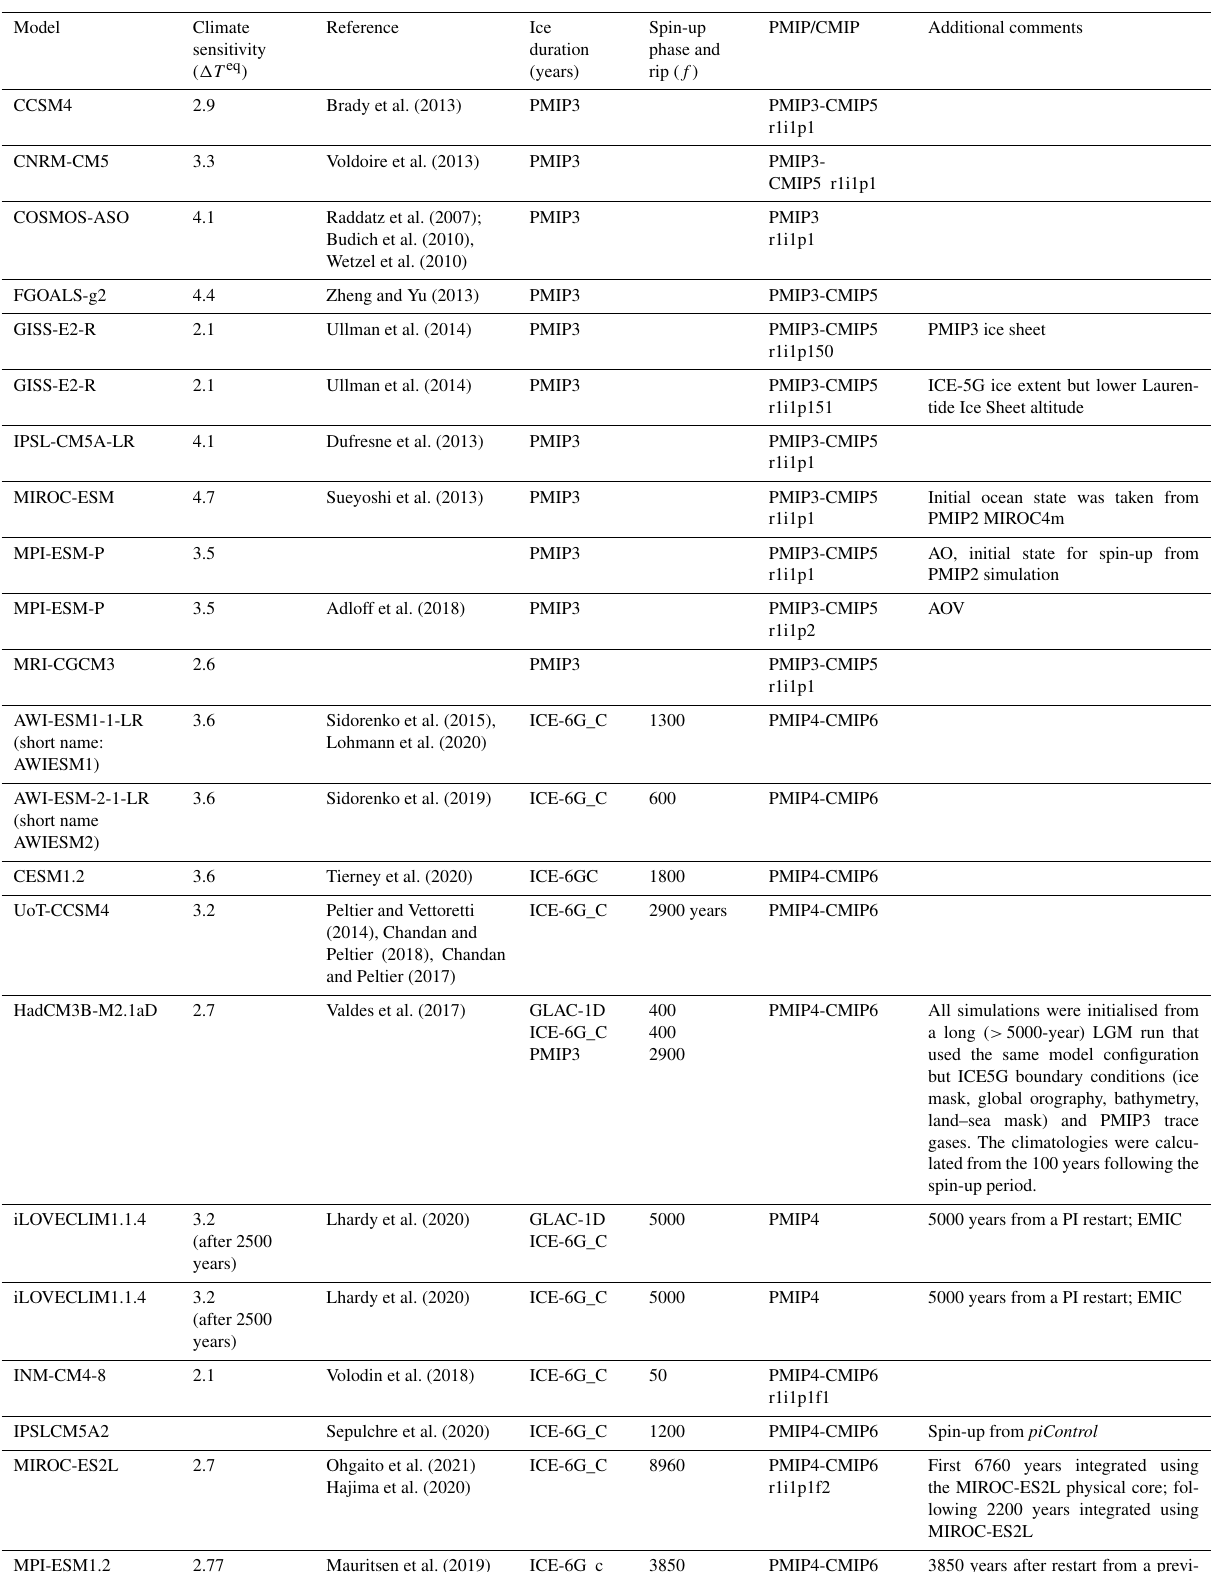
Table 1. PMIP3 and PMIP4 models analysed in the present study. The spin-up duration is only given for the new PMIP4-CMIP6 models.